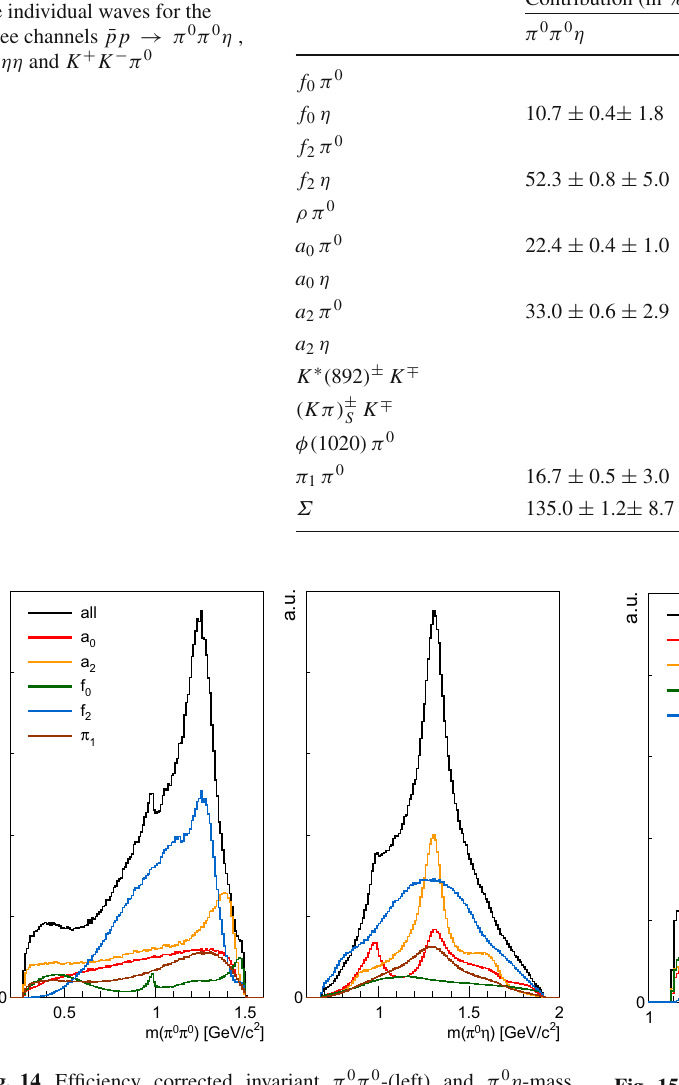
Fig. 15 Efficiency corrected invariant ηη -(left) and π 0 η -mass (right) for the reaction ¯ pp → π 0 ηη . The overall result is marked in black, while the individual contributions are visualized by different colors located not too far from the real axis and not too close